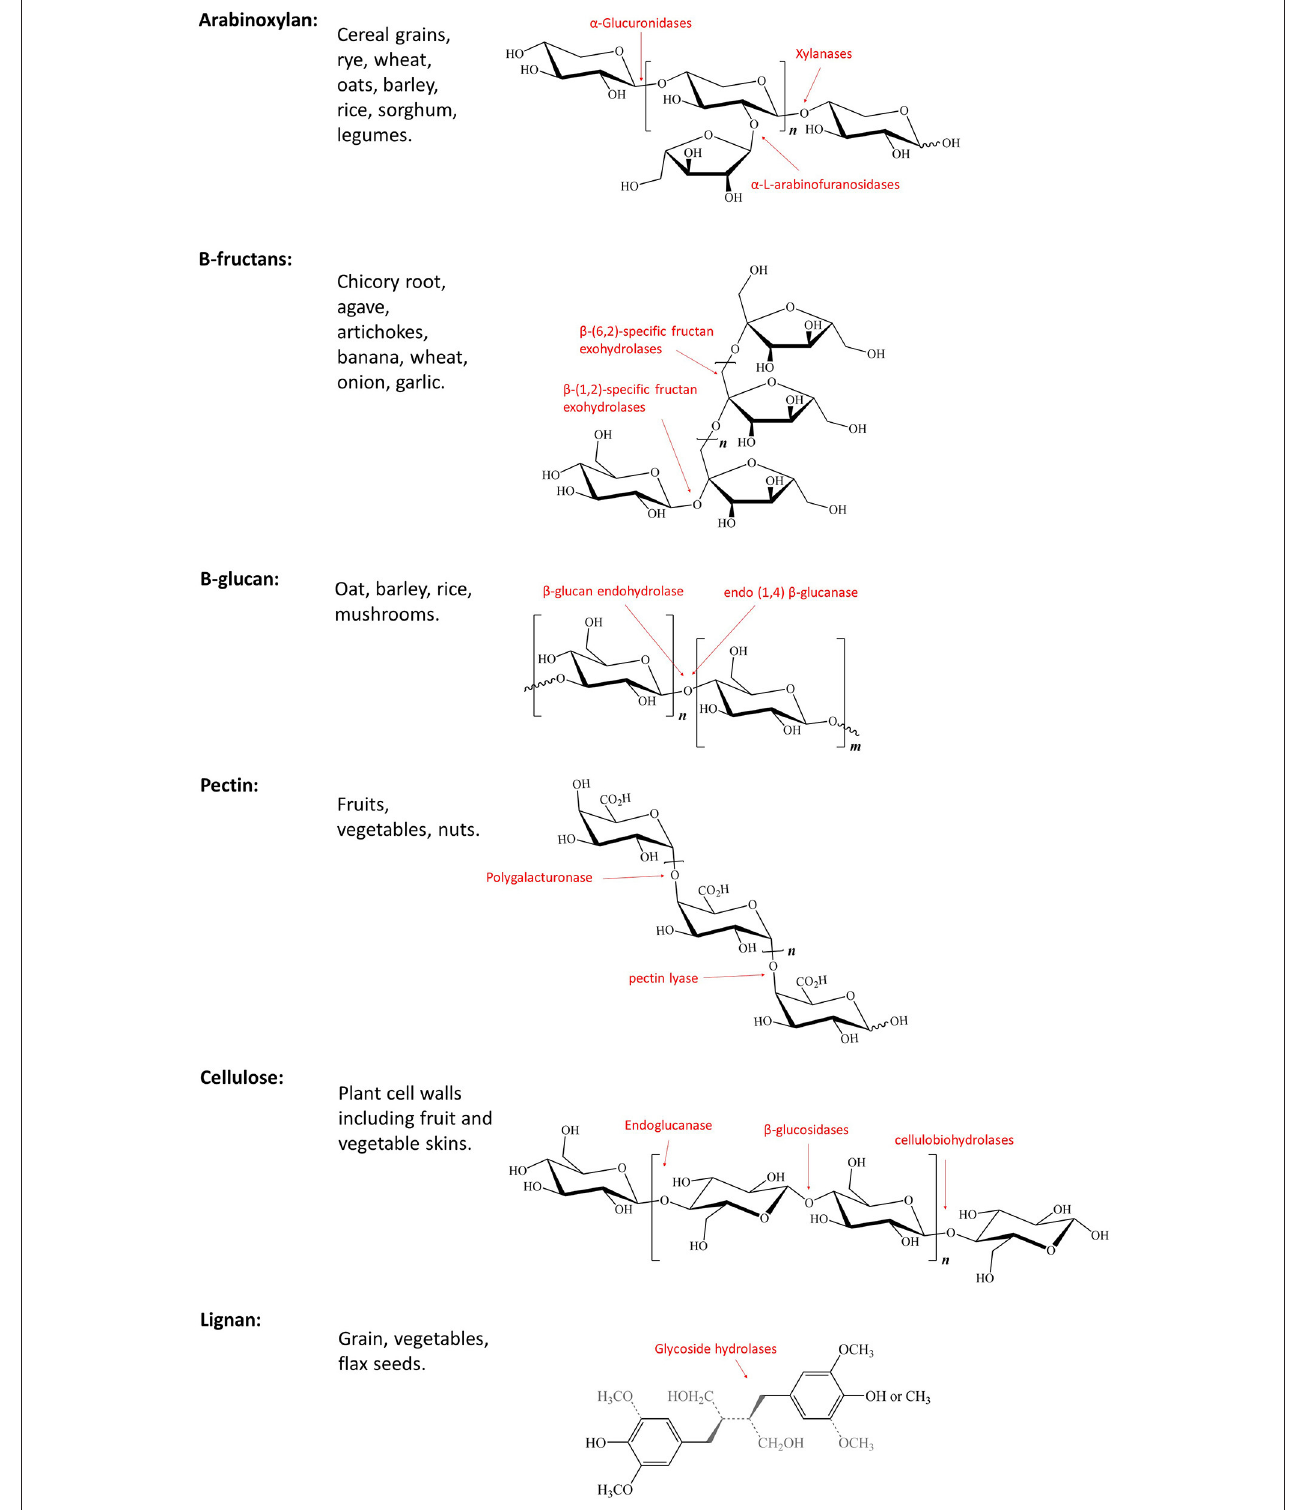
FIGURE 1 | Not all Fibers are born equal; Structure, classification, and chemical features of key dietary fibers with key enzymes highlighted in red.